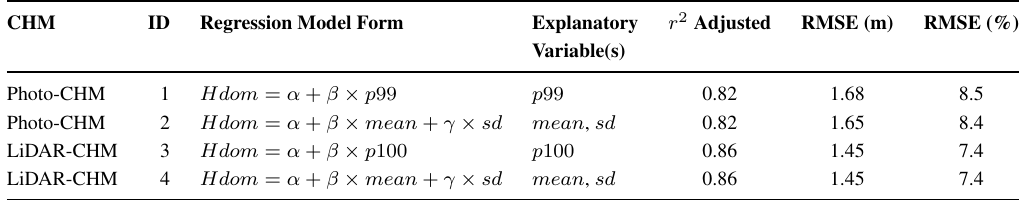
Table 4. Comparison of dominant height ( Hdom ) models for deciduous irregular stands ( n = 36) based on photo-CHM and LiDAR-CHM metrics. Model performance is described in terms of adjusted r 2 , root-mean-square error (RMSE) (m) and relative RMSE (%). ID stands for model identification number.